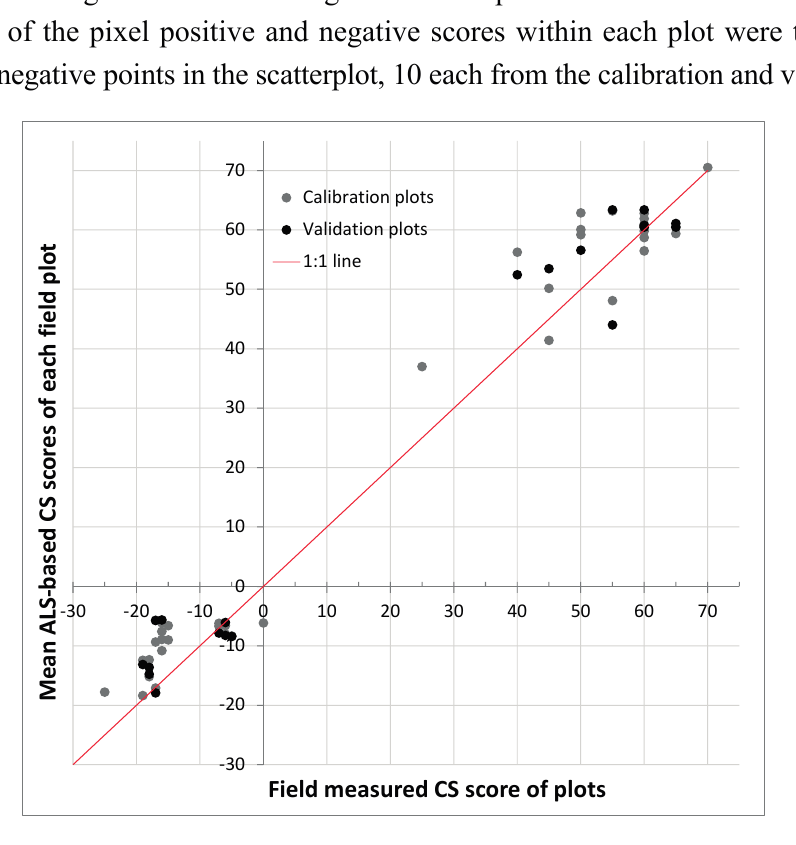
Figure 5. Scatterplot of plot-level positive and negative CS score from field mapping vs. ALS-based positive and negative CS score averaged for each